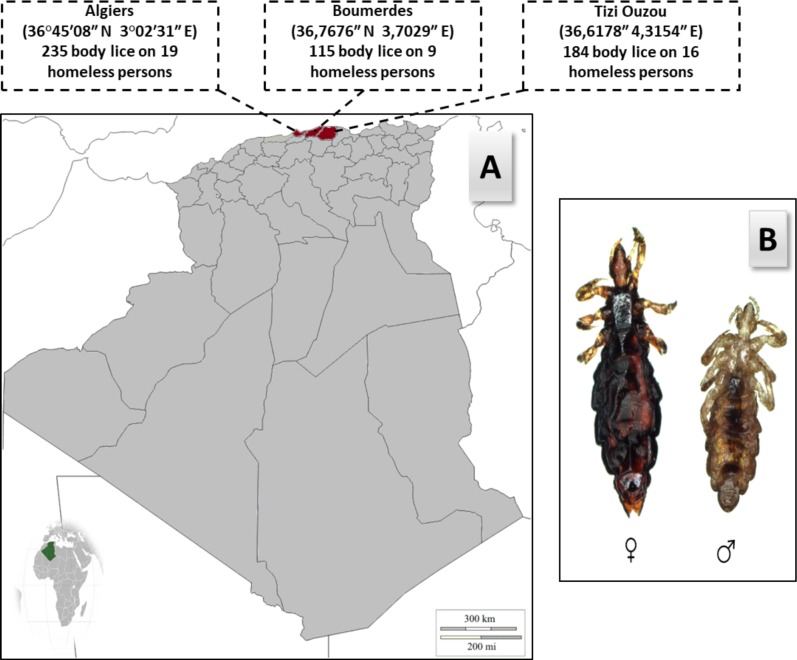
(A) Map of body lice collection from homeless populations in three localities in northern Algeria. Red pins indicate sampling sites. (B): Human body lice collected from the homeless population.